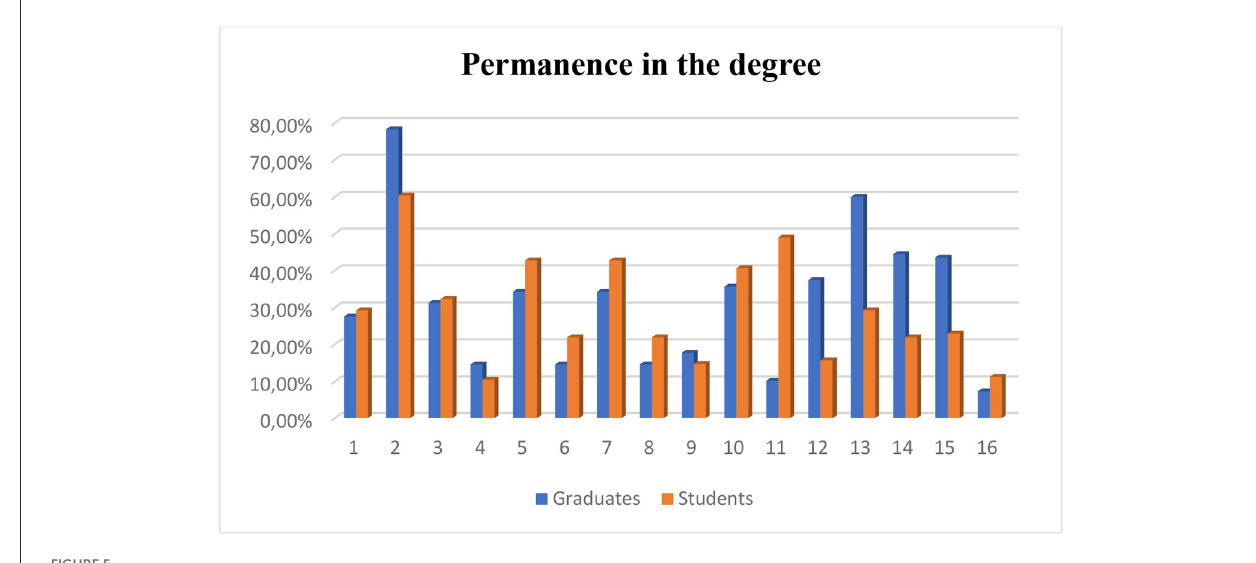
FIGURE5 Reason for remaining in university studies.